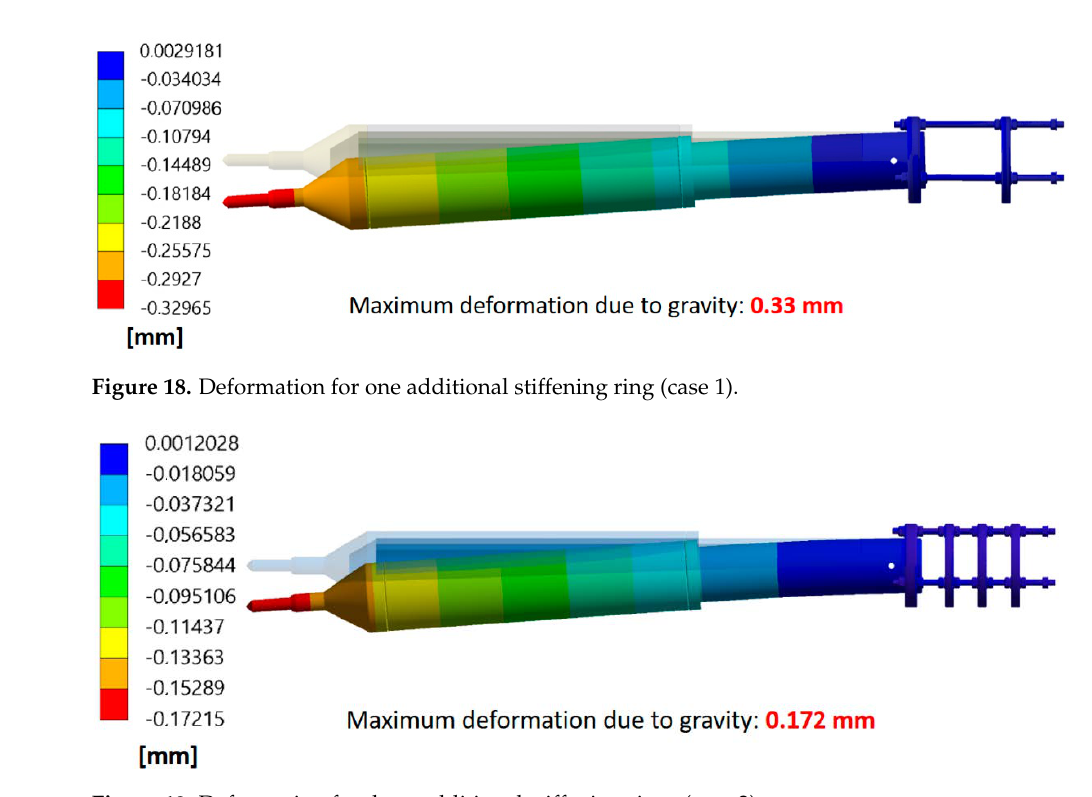
Figure 17. Assembly of the tube insert.